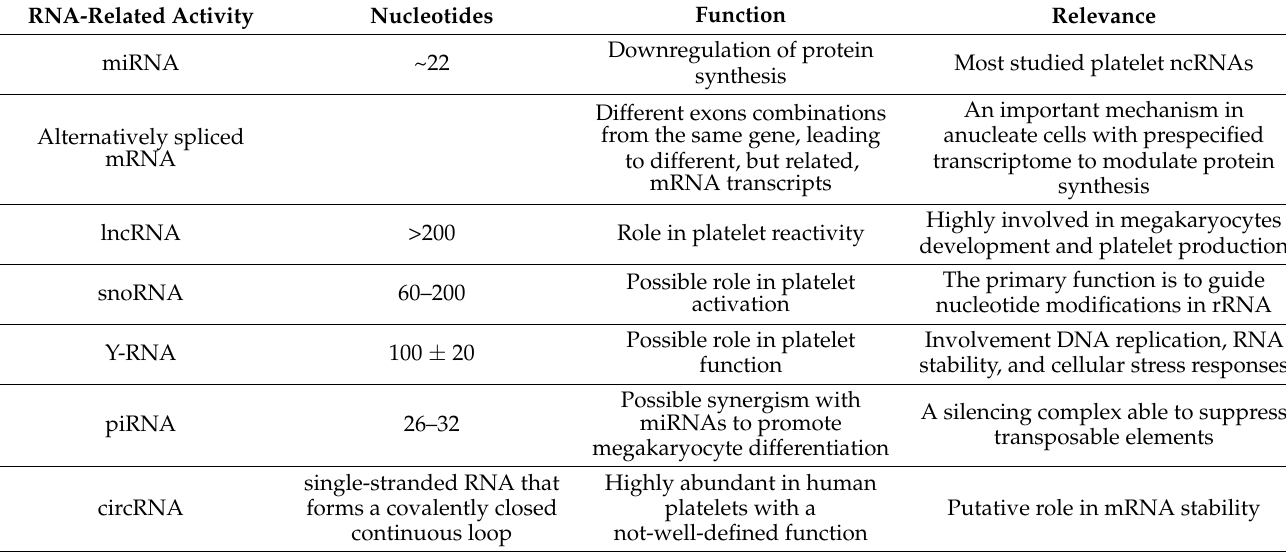
Table 1. RNA-related mechanisms involved in platelet function.